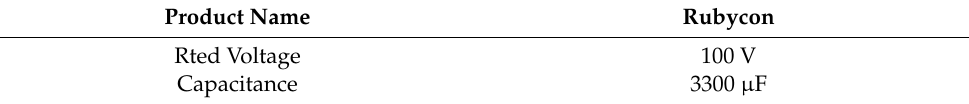
Table 4. Specifications for four energy-transferring